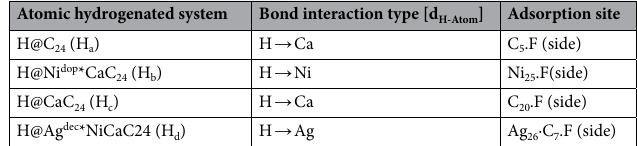
Atomic hydrogenated